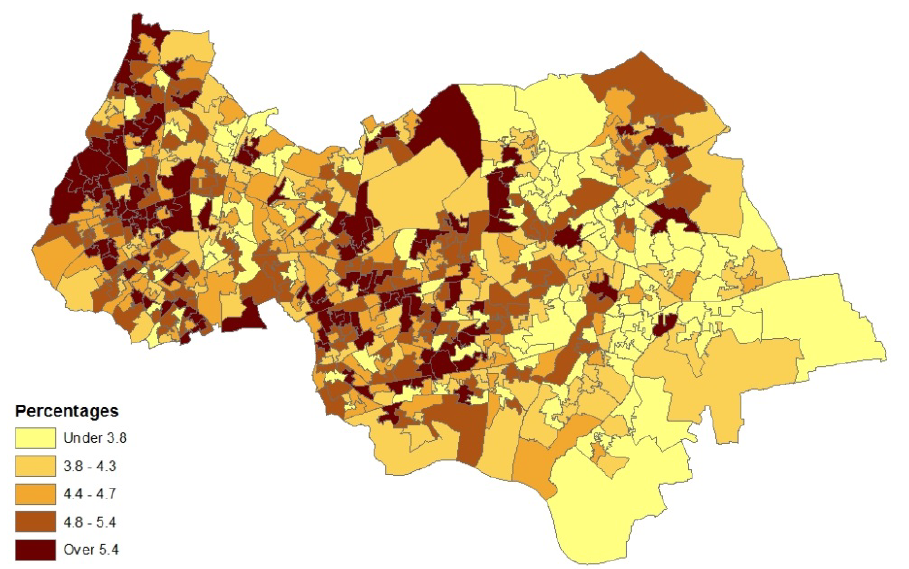
Figure 3. Asthma prevalence (%), LSOAs, outer NE